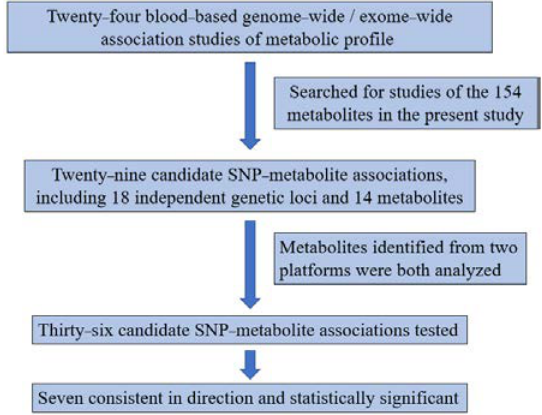
Figure 3. Diagram of the candidate gene–metabolite associations.